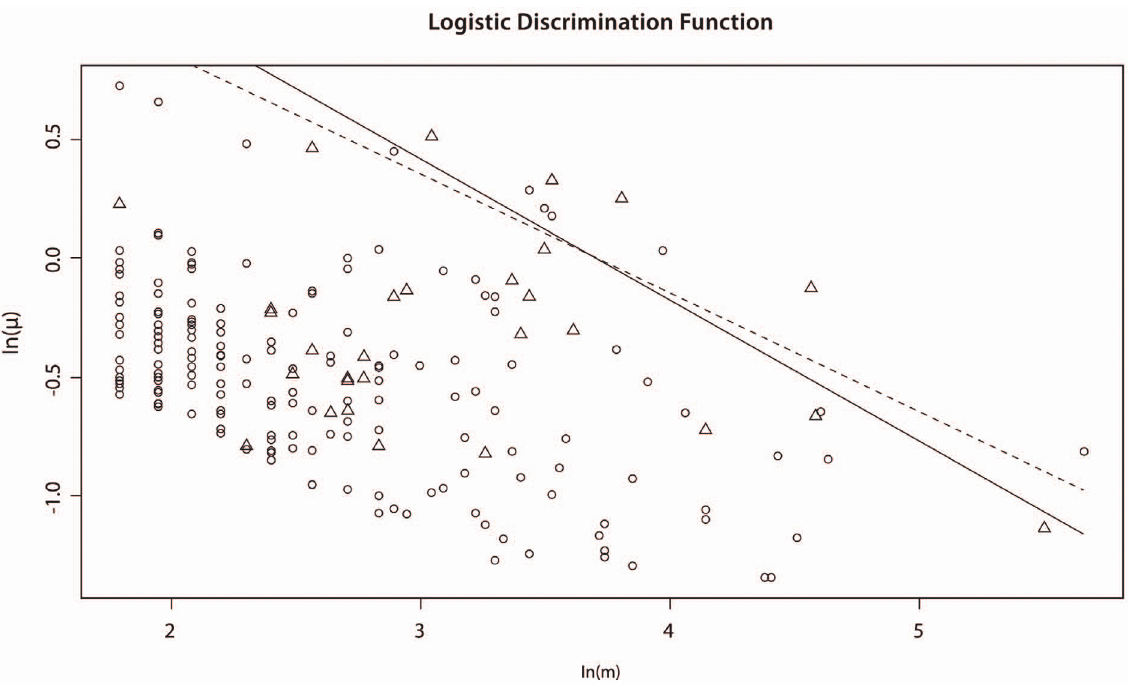
Figure 4. Logistic discrimination functions for Illumina Hapmap data corresponding to optimal score ( a =0.59, solid line) and statistical information score ( a =0.5, dashed line). Triangles correspond to true positives, ellipses to false positives.